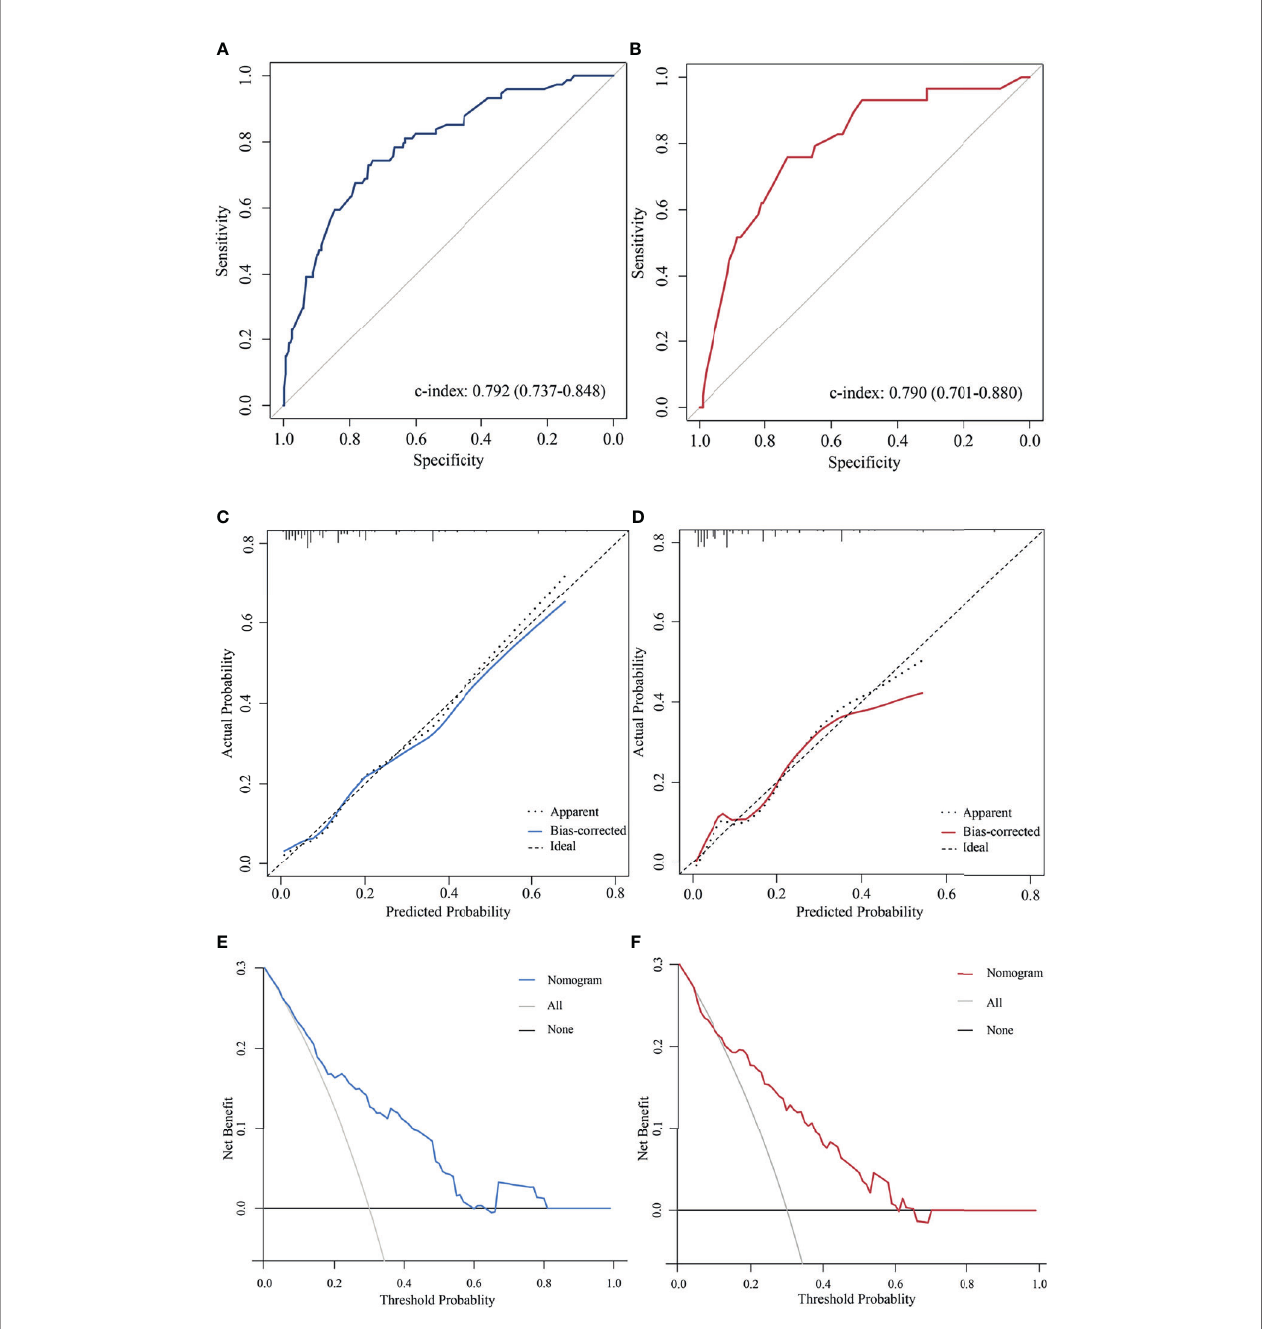
FIGURE 2 | Validation the predictive value of the AAPR-based nomogram. The ROC curves for the nomogram model in (A) the training cohort and (B) validation cohort. The calibration plots for the nomogram model in (C) the training cohort and (D) validation cohort. The decision curves show the net-bene fi t of using the nomogram in (E) the training cohort and (F) validation